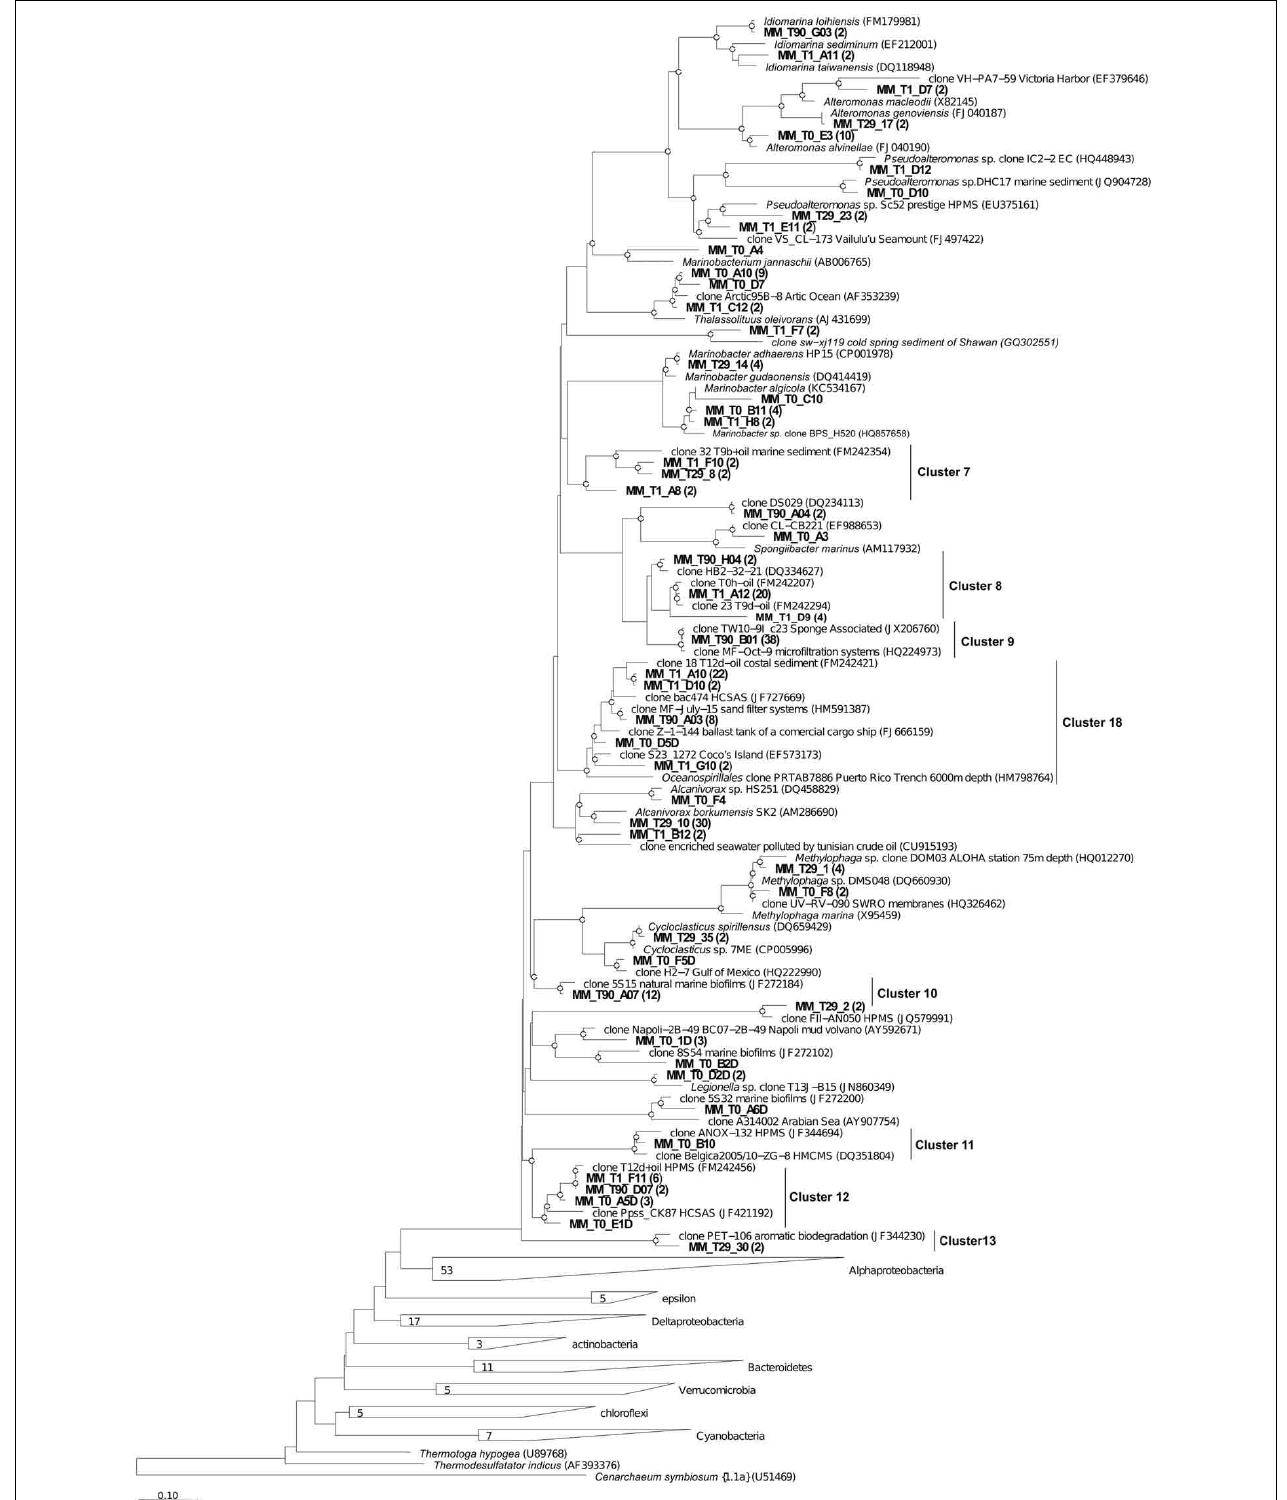
FIGURE 7 | Phylogenetic affiliation of the Gammaproteobacteria clones retrieved in Messina harbor sediments and in mesocosm experimen- tation. Neighbor-joining analysis using 1000 bootstrap replicates was used to